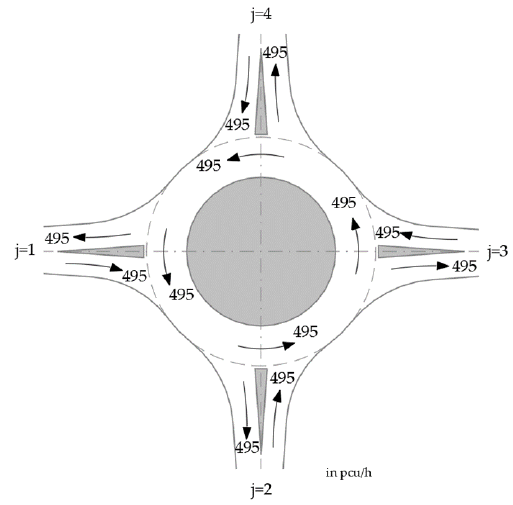
Figure 7. Calculated values of entering, exiting, and circulating traffic flow in pcu/h.